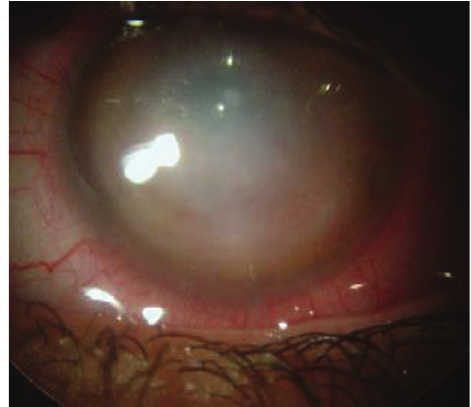
Figure 2: Four weeks after the start of ceftazidime treatment, we noticed a central corneal scar, absence of hypopyon, and no evidence of active keratitis.